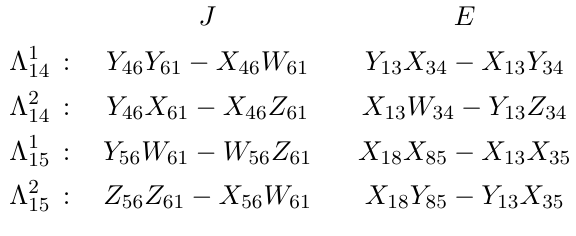
Figure 29 . Quiver diagram for phase J of Q 1 , 1 , 1 / Z 2